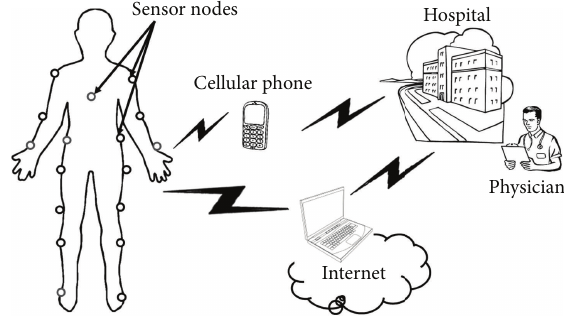
Figure 1: Schematic diagram of wireless body sensor networks